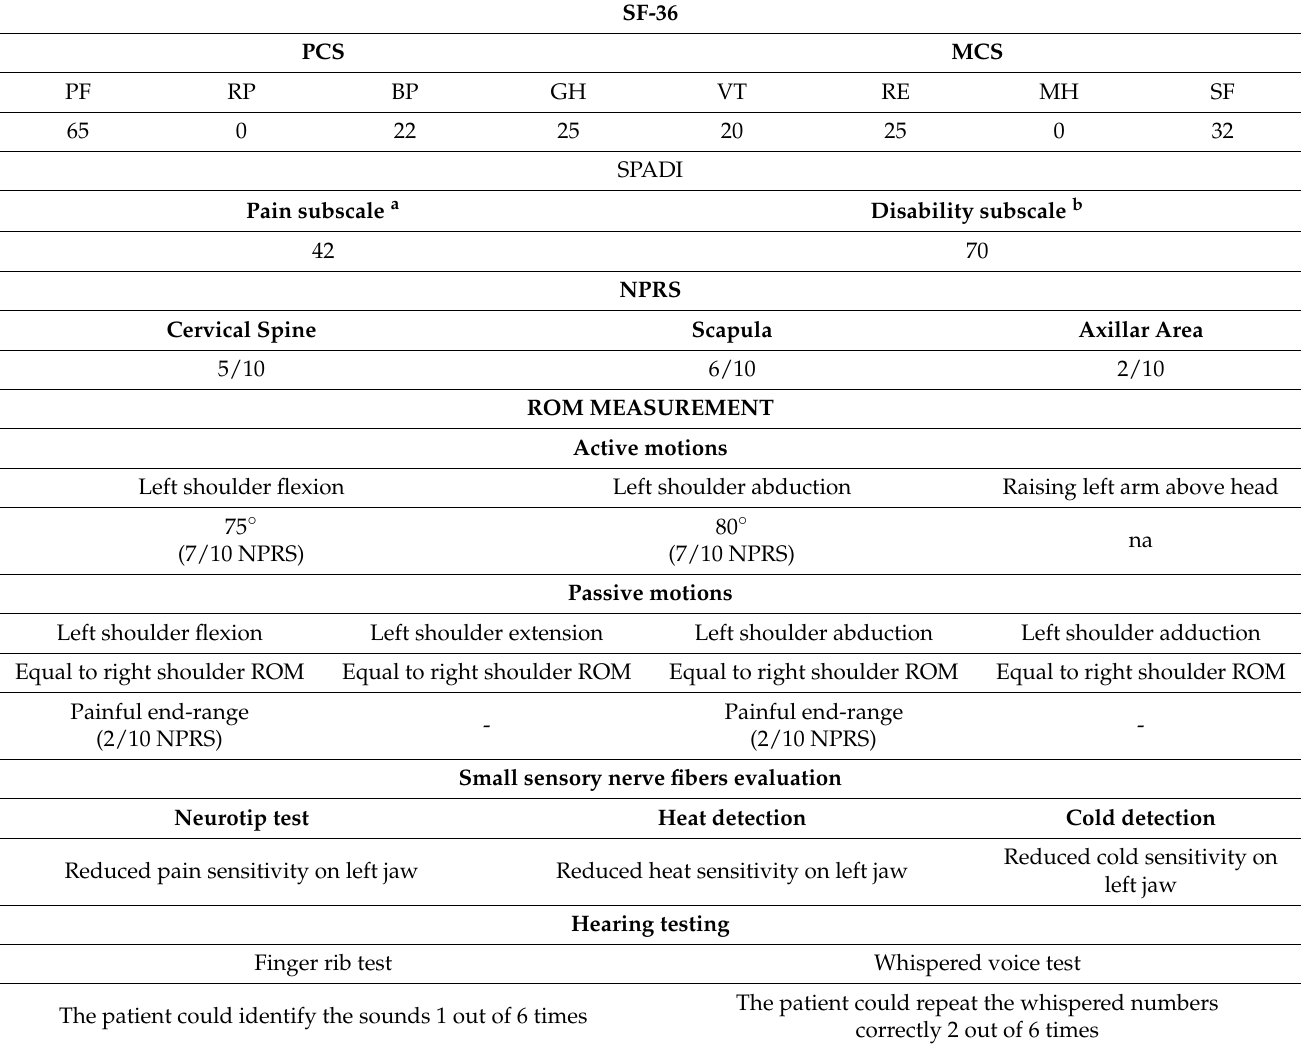
Table 2. Outcome measure. Baseline